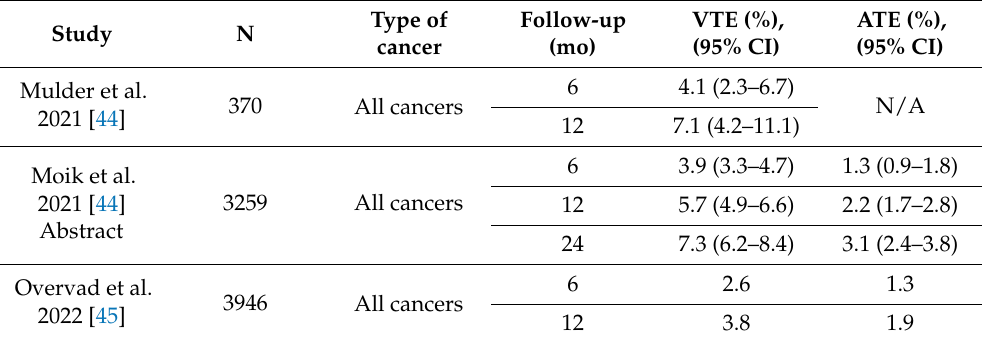
Table 3. Summary of incidence of VTE and ATE from population cohort studies (all from Danish